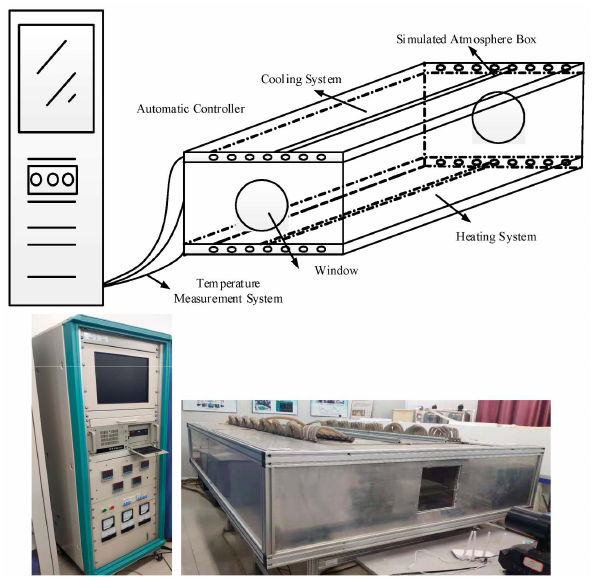
Figure 2. Schematic diagram of the overall structure of the hot air convection type atmospheric turbulence emulation